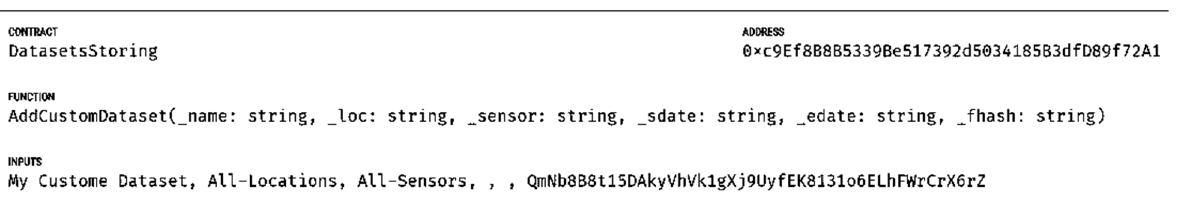
Figure 7. Data in the blockchain ledger.